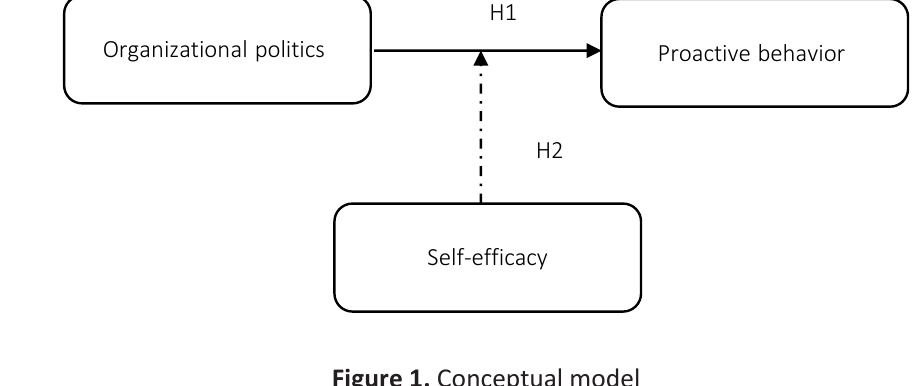
Figure 1. Conceptual